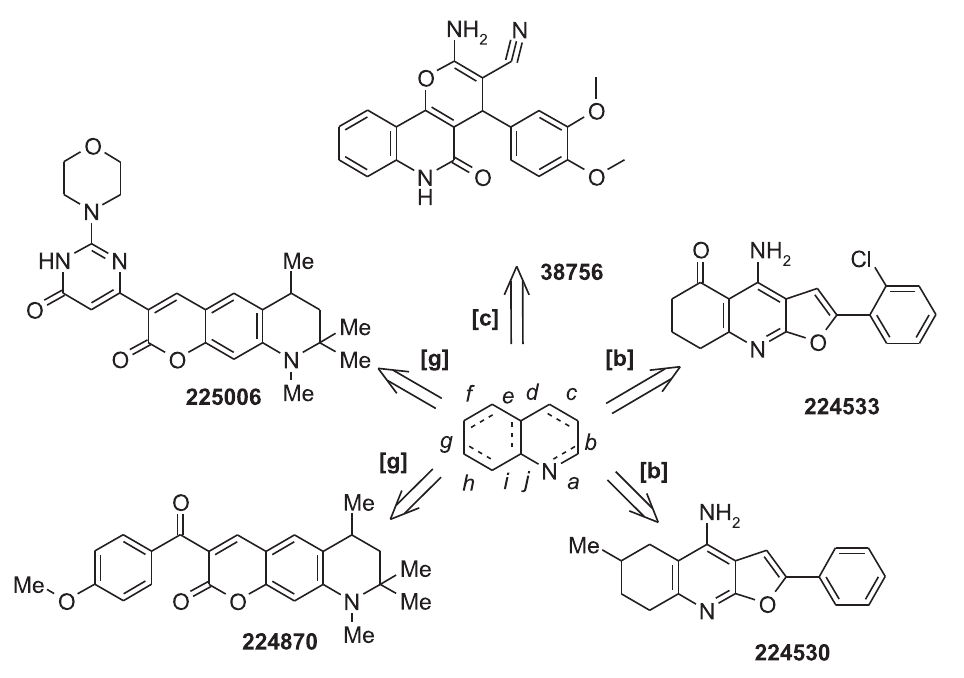
Figure 8. Structures of tricyclic hydroquinolines annelated at the [c], [g], and [b] bonds.